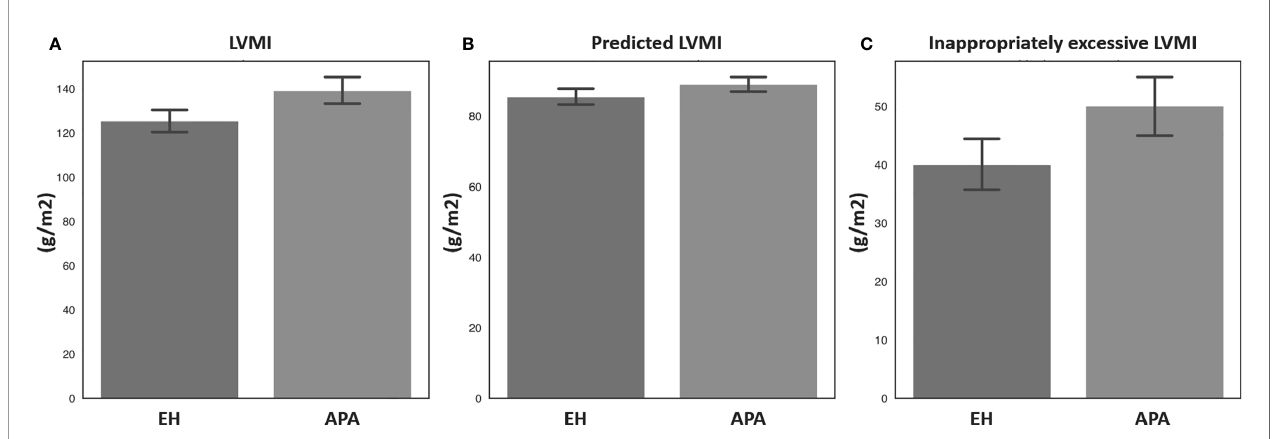
FIGURE 1 | Comparisons of (A) LVMI, (B) predicted LVMI, and (C) inappropriately excessive LVMI between patients with aldosterone-producing adenoma and essential hypertension after propensity score matching. APA, aldosterone-producing adenoma; EH, essential hypertension; LVMI, left ventricular